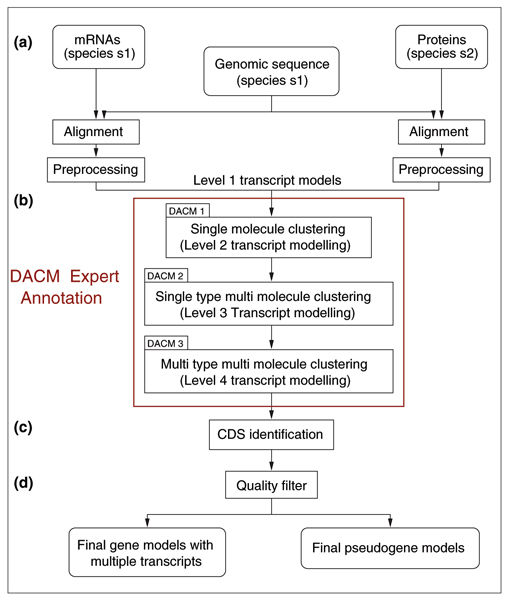
Overview of the Exogean methodology. Exogean annotations are based on protein and/or mRNA alignments. Protein sequences come from a different species than that of the DNA to be annotated (for example, mouse protein to annotate human genes), while the mRNAs originate from tissues of the species being annotated. (a) These alignments are first processed to remove artifacts using heuristics. (b) The core of the method is the directed acyclic multigraph (DACM) component, which builds transcripts of increasing complexity in three iterative steps using a second set of heuristics. (c) The transcripts are then examined to identify a complete or a partial coding sequence (CDS), and (d) a last filter applies a last set of rules to remove pseudogenes.